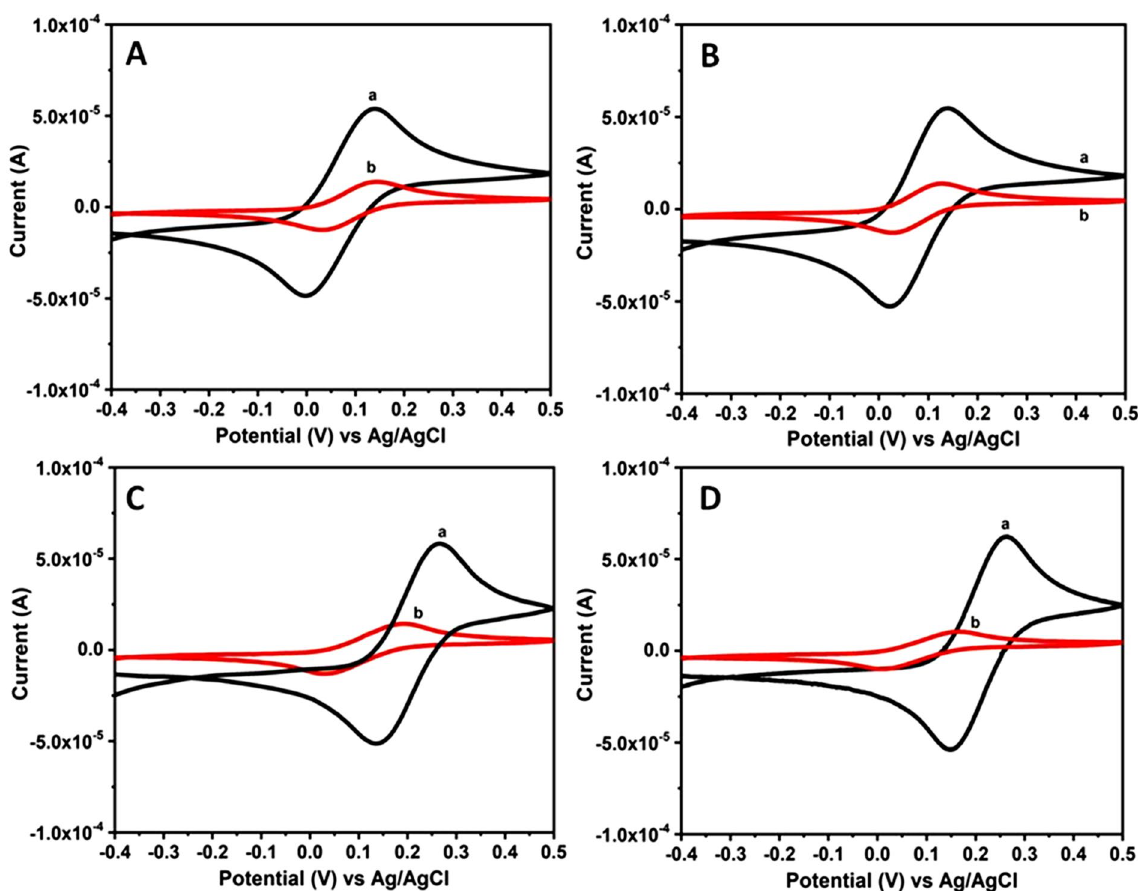
Figure 3. CV curves of Au and Pt electrodes recorded using sweat and saliva bio-mimic solutions at a fixed scan rate of 50 mV/s. ( A ) Au and ( B ) Pt electrodes in artificially simulated sweat solution + Fe 2+/3+ redox couple + Triton X-100. Similarly ( C ) Au and ( D ) Pt electrodes in artificial saliva solution + Fe 2+/3+ redox couple + Triton X-100. These CVs are recorded for 1 mM [Fe(CN) 6 ] 3−/4− redox couple containing 0.1 M NaCl in absence (a) and in presence (b) of Triton X-100 composition